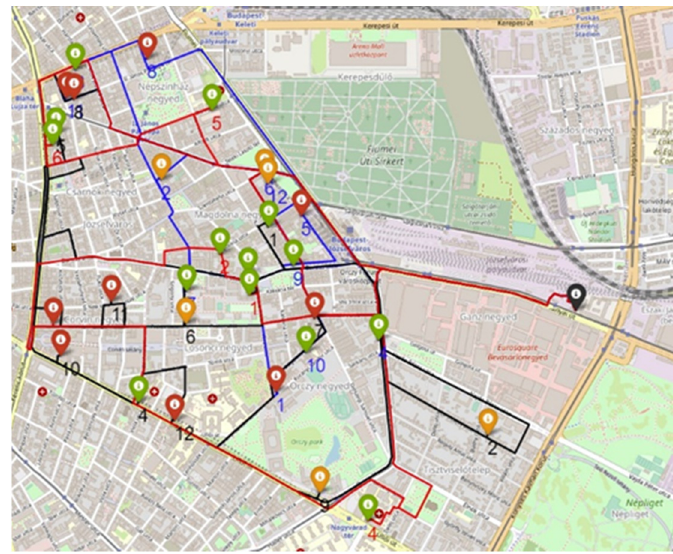
Figure 9. Actual routes when using a random solution.